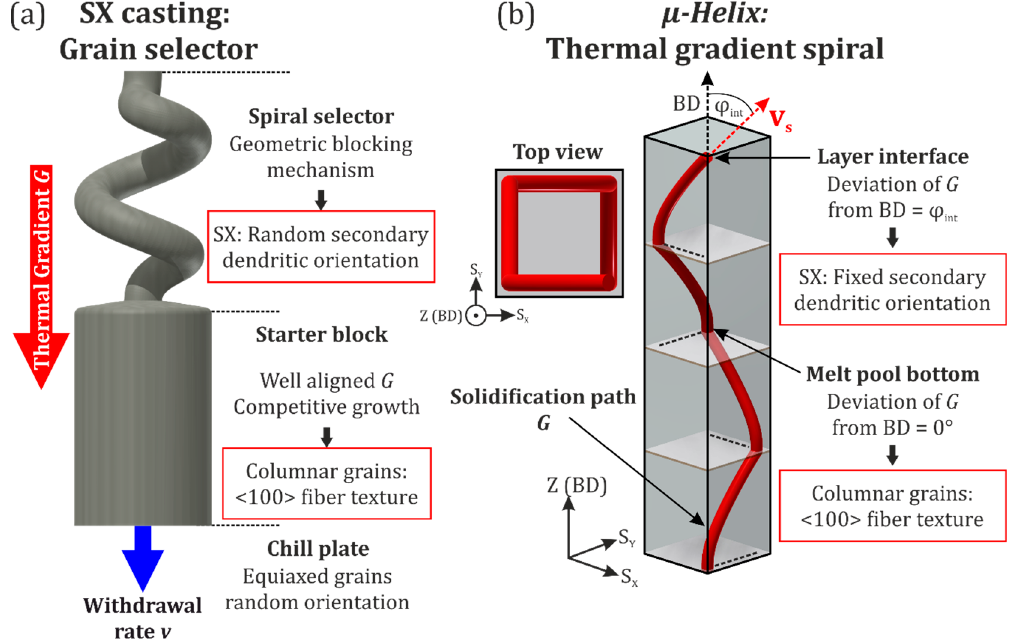
Figure 11. Schematic illustration of different approaches to realize single crystals. ( a ) Physical spiral grain selector used within an investment casting mold, ( b ) µ-Helix selector during SEBM formed by the direction of the local thermal gradient G.